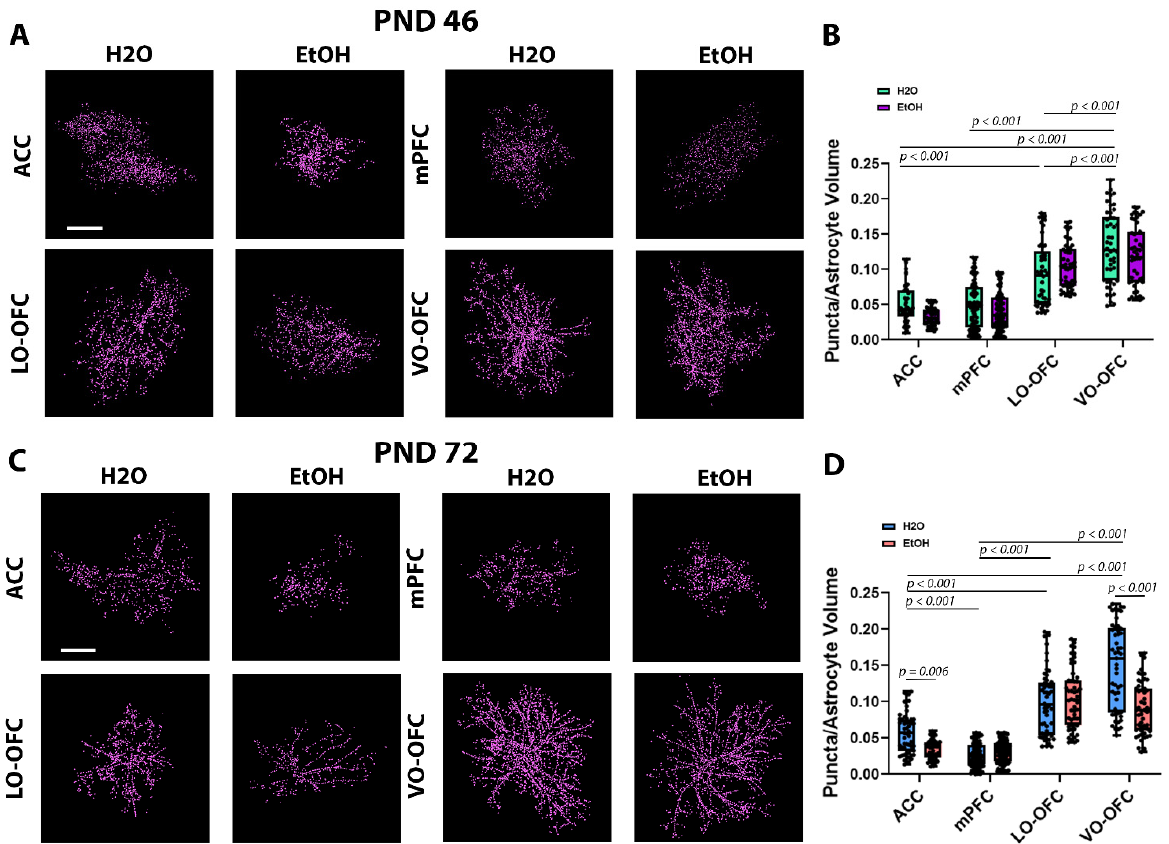
Figure 3. Single astrocyte co-localization with PSD-95 and analysis 24 h (PND 46) and 26-days (PND 72) after AIE. ( A ) Representative images of PSD-95 colocalized within 0.5 µ m of a Lck-GFP + astrocyte in the ACC, mPFC (IL and PL), LO-OFC, and VO-OFC 24 h after AIE. Scale bar 20 µ m. ( B ) Quantification of puncta/astrocyte volume (puncta/ µ m 3 ) in each of the PFC subregions. When comparing puncta number across subregions within the control groups, there was a significant increase in puncta number/astrocyte volume in LO-OFC and VO-OFC when compared to ACC and mPFC. There was no significant treatment effect on puncta number (H 2 O vs. EtOH) within subregions. ( C ) Representative images of PSD-95 colocalized within 0.5 µ m of an AAV+ astrocyte in the ACC, mPFC (IL and PL), LO-OFC, and VO-OFC 26-days after AIE. Scale bar 20 µ m. ( D ). When comparing puncta number across subregions within the control groups, there was a significant increase in puncta number/astrocyte volume in LO-OFC and VO-OFC when compared to ACC and mPFC. There was a significant treatment effect on puncta number (H 2 O vs. EtOH) demonstrated by a decrease in astrocyte-synapse co-localization in the ACC ( p < 0.006) and the VO-OFC ( p < 0.001). Data presented as box and whisker plots with interquartile range with mean, minimum, and maximum measures indicated along with individual data points. Analysis: two-way ANOVA with Tukey’s post hoc comparison, n = 5/treatment group.